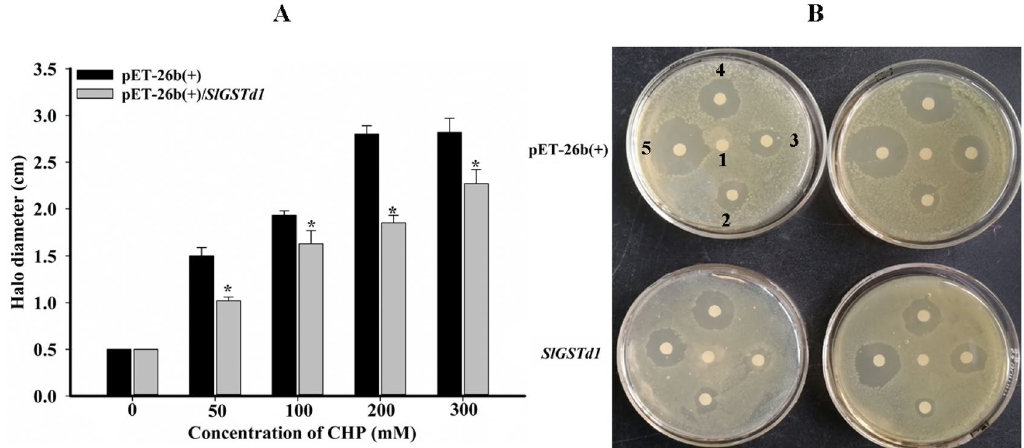
Figure 5. Inhibition zone halo diameter of E. coli expressing pET-26b(+)/ SlGSTd1 and pET-26b(+) under different concentrations of CHP ( A , B ). ( A ) Error bar indicated SD of three replication. *Indicated significant differences between comparative groups ( P < 0.05, student’s t-test). ( B ) Labels 1–5: 0, 50, 100, 200, 300 mmol L −1